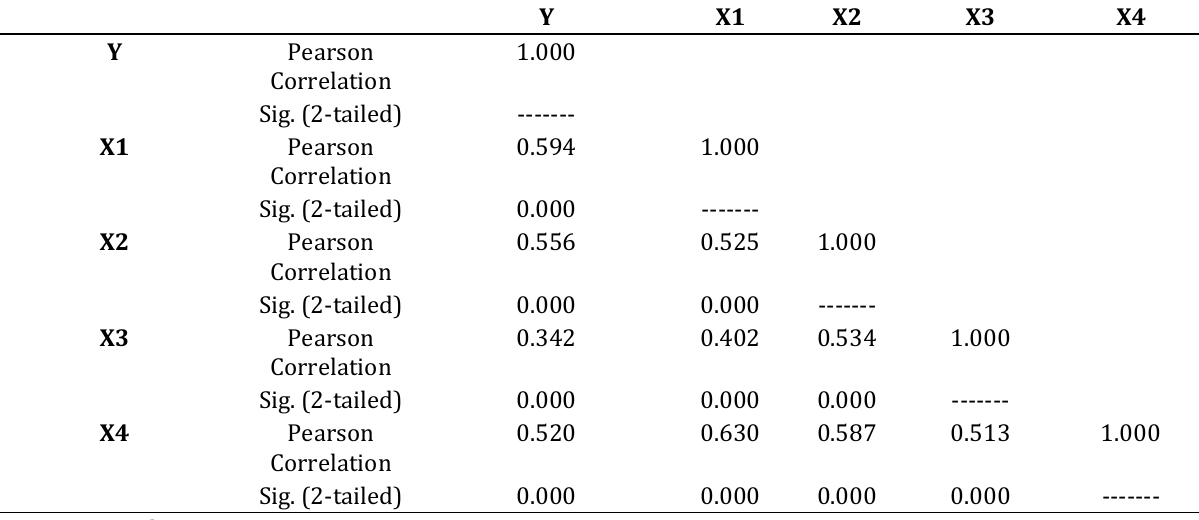
Table 21: Correlation Matrix between Y and X1-X4 Y X1 X2 X3 X4 Y Pearson Correlation